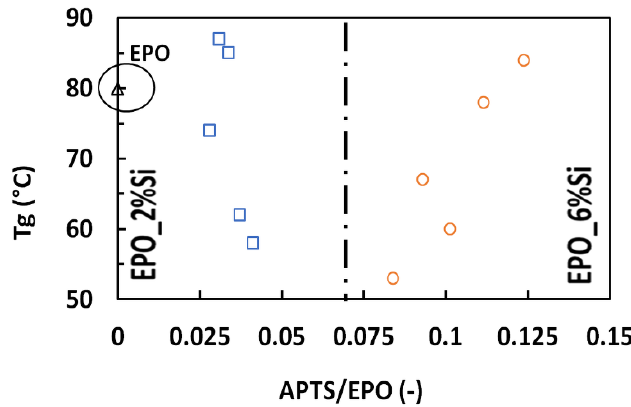
Figure 4. T g vs. APTES/epoxide weight ratio. In particular, blue squares represent samples con- taining 2 wt.% silica; orange circles indicate samples containing 6 wt.% silica and the black triangle displays pristine